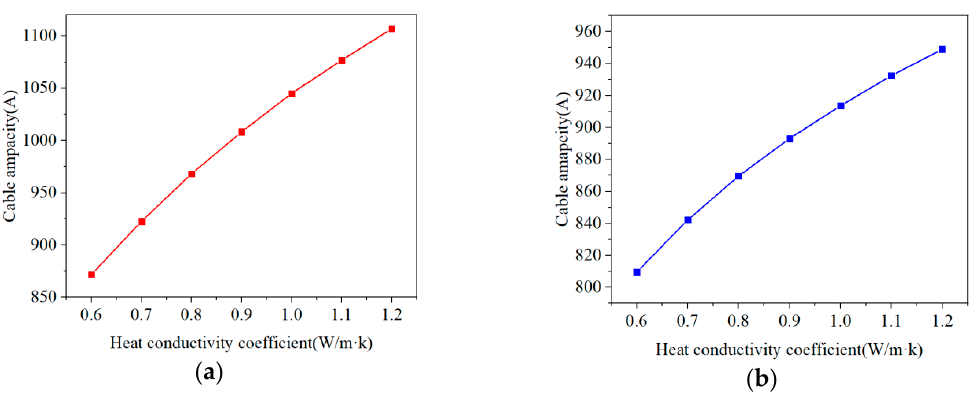
Figure 12. The submarine cable ampacity for two laying methods with different soil thermal conductivity. ( a ) Submarine cable ampacity for direct burial laying with different thermal conductivity of soil. ( b ) Submarine cable ampacity for pipe laying different thermal conductivity of soil.